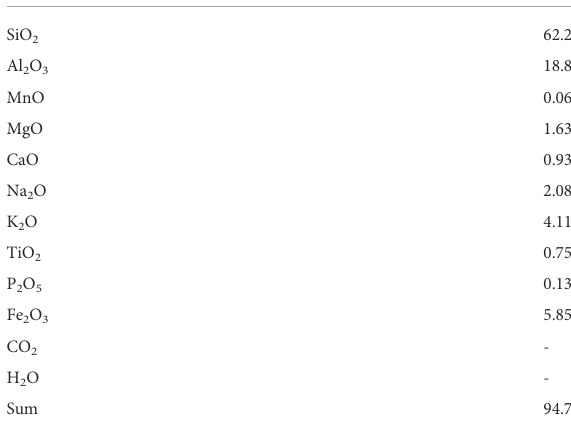
TABLE 2 Major (wt%) element composition of the garnet bearing micaschist FO1710 sample used for pseudosection calculations. wt% initial SiO